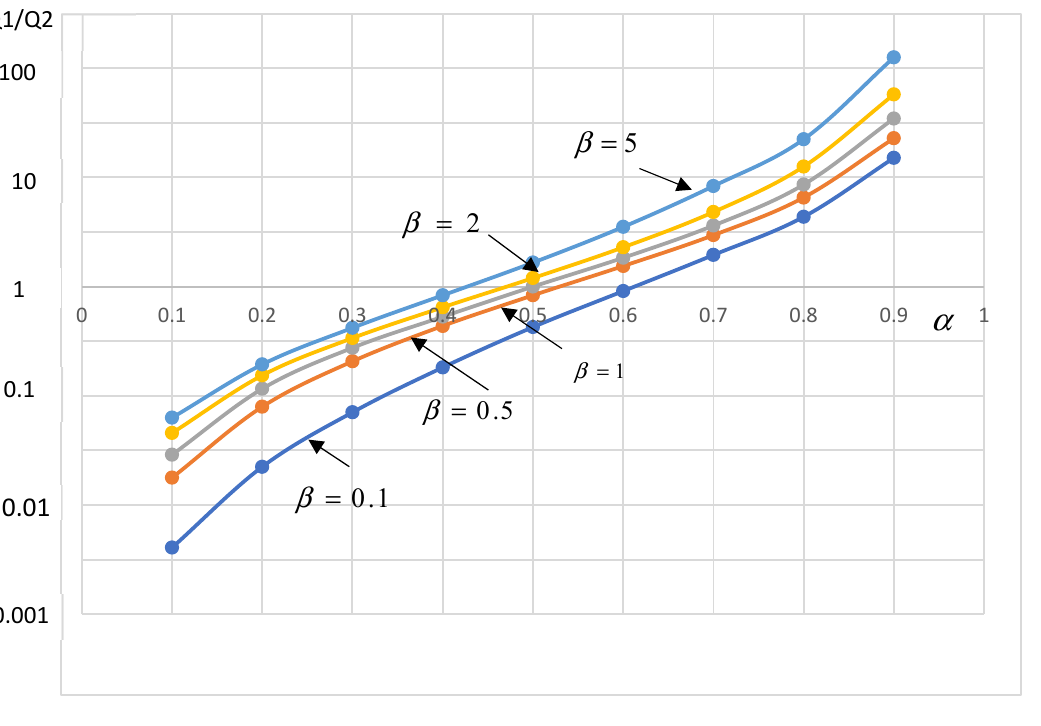
α Figure 9. Interface position as a function of the flow rate ratio for different values of the viscosity Figure 9. Interface position α as a function of the flow rate ratio for different values of the viscosity β ratio . ratio β